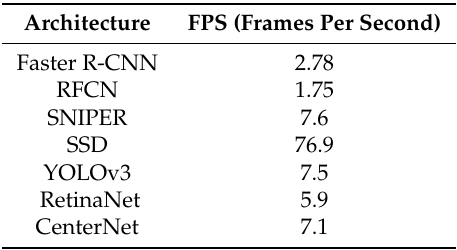
Table 3. Runtime performance of Faster R-CNN, RFCN, SSD, YOLO, SNIPER, RetinaNet with VisDrone2019 on GeForce RTX 2080 Ti